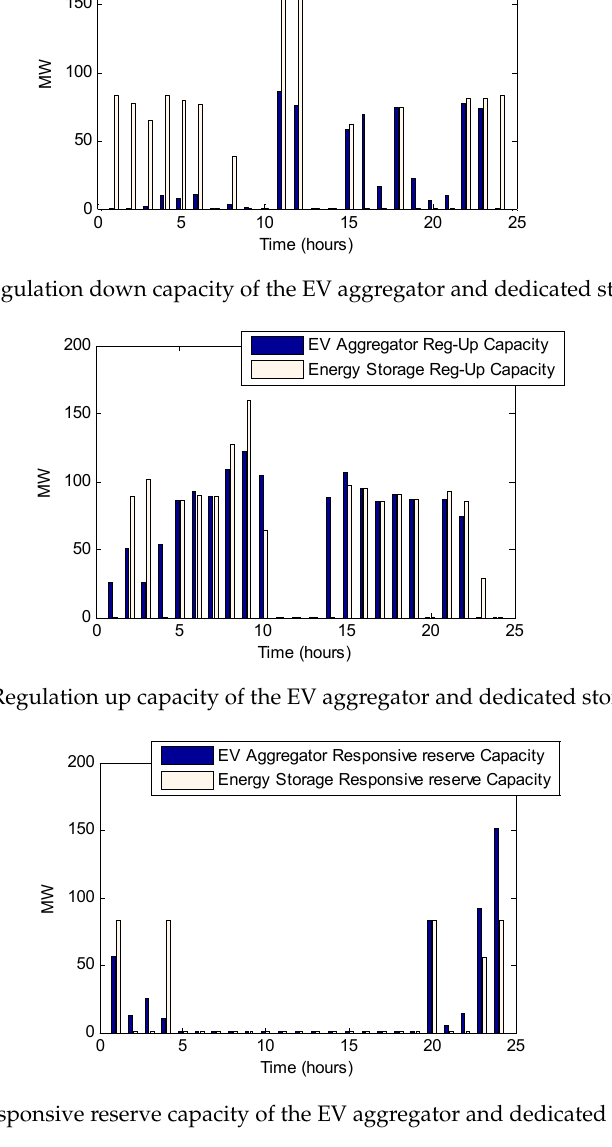
Figure 10. Responsive reserve capacity of the EV aggregator and dedicated storage unit.